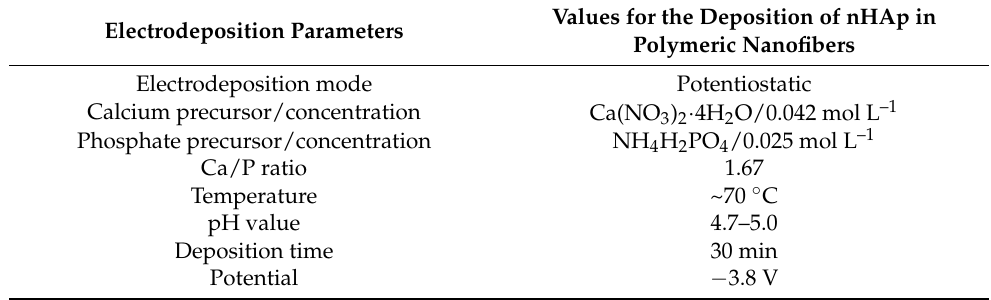
Table 1. Electrodeposition parameters adjusted for the formation of nHAp coating on the surface of polymer-based nanofibrous scaffolds.